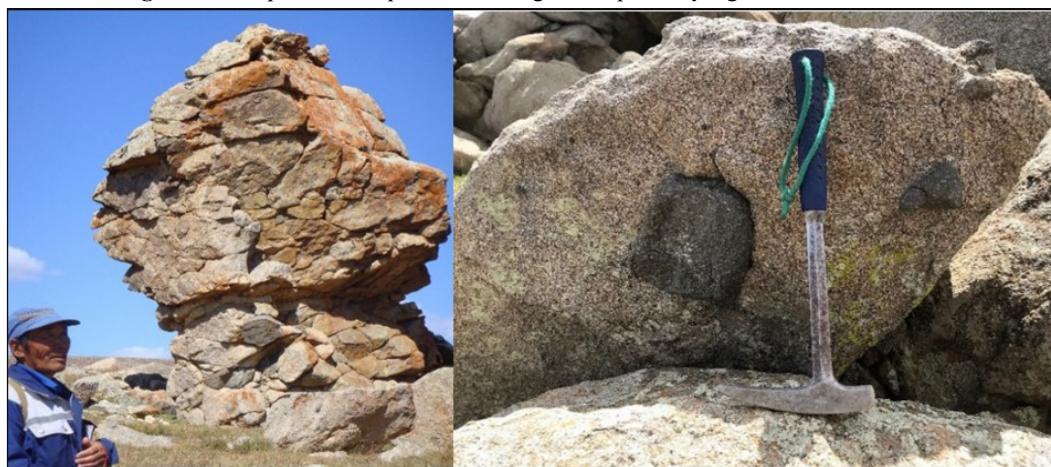
Fig. 5. Outcrop of second phase of Khangai Complex, Uyanga